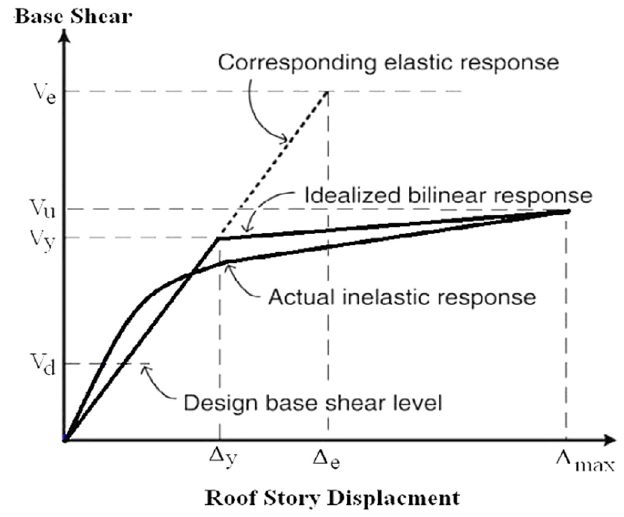
Figure 5. The general response of a structure .